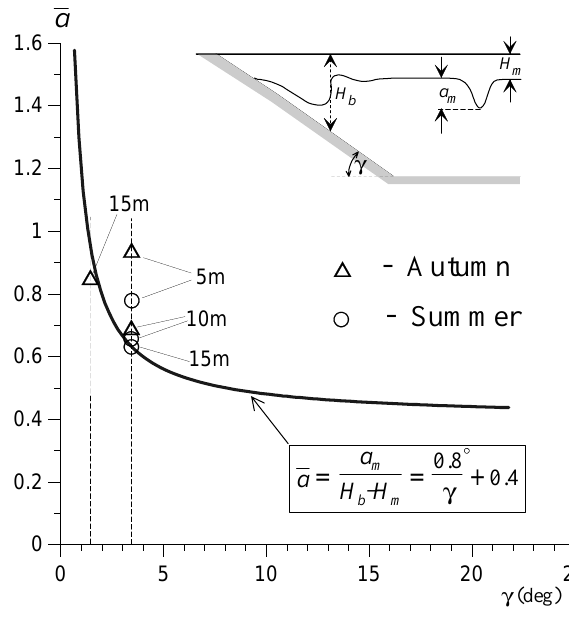
Fig. 13. Breaking events obtained in the model. All designations are presented in the figure. The insert sketch explains the parameter used for the breaking